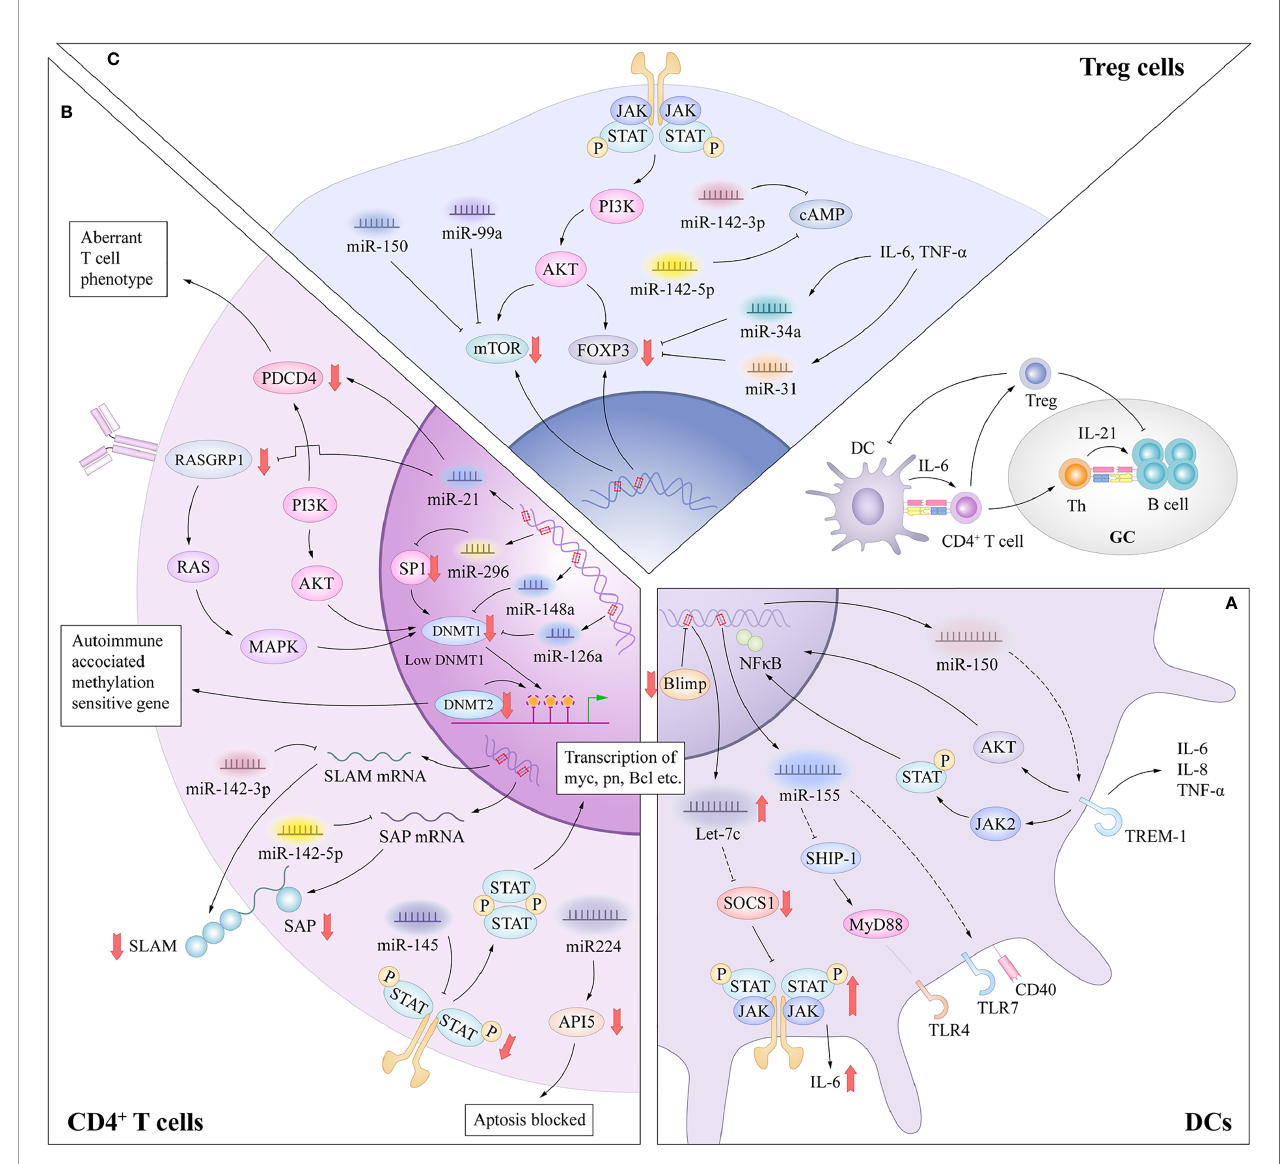
FIGURE 2 | (A) MiRNAs in dysfunctional antigen presentation by DCs. In the DC-speci fi c absence of Blimp1, an increase in let-7 miRNA results in a broad spectrum of proin fl ammatory DC phenotype, mediated in part through suppression of SOCS1 expression. The CD40 expression was signi fi cantly upregulated with a negative correlation to the miR-155 in SLE primary target SHIP-1 expression. MiRNA-150 inhibited the expression of TREM-1 which amplify the function of TLR4. (B) miRNAs in aberrant activation of CD4 + T cells. MiR-21 contributed to the aberrant phenotype of T cells through interaction with PDCD4 or indirectly inhibiting DNMT1 expression through targeting RASGRP1. miRNAs such as miR-126, miR-29b and miR-148a can directly inhibit DNMT1 expression by targeting the protein coding region. These processes result in the overexpression of autoimmune-associated methylation-sensitive genes, which contribute to the autoreactivity and overstimulation of CD4 + T cells in SLE. miR- 142-3p speci fi cally targets the SLAM family, while miR-142-5p targets the 3 ’ -UTR of SAP. Thus, decreased miR-142-3p/5p expression contributes to the up-regulation of CD84 and IL-10/SAP, resulting in the increased T cell function and IgG production in co-cultured B cells. Aberrant expression of miR-145 and miR-224 can promote T cell activation-induced cellular apoptosis and SLE-associated nephritis by overexpression of STAT1 and underexpression of API5. (C) miRNAs in functional inhibitory of Treg cells. The release of IL-6 or TNF- a can increase the expression levels of miR-34a, which can attenuate Foxp3 expression by targeting its 3 ʹ -UTR. MiR-142-5p positively regulates intracellular levels of cAMP to maintain the suppressive function of Treg cells. MiR-142-3p can restrict cAMP levels in CD4 + T cells, which compromises the inhibitory function of Treg cells. MiR-99a and miR150 could regulate the function of Treg cells by targeting